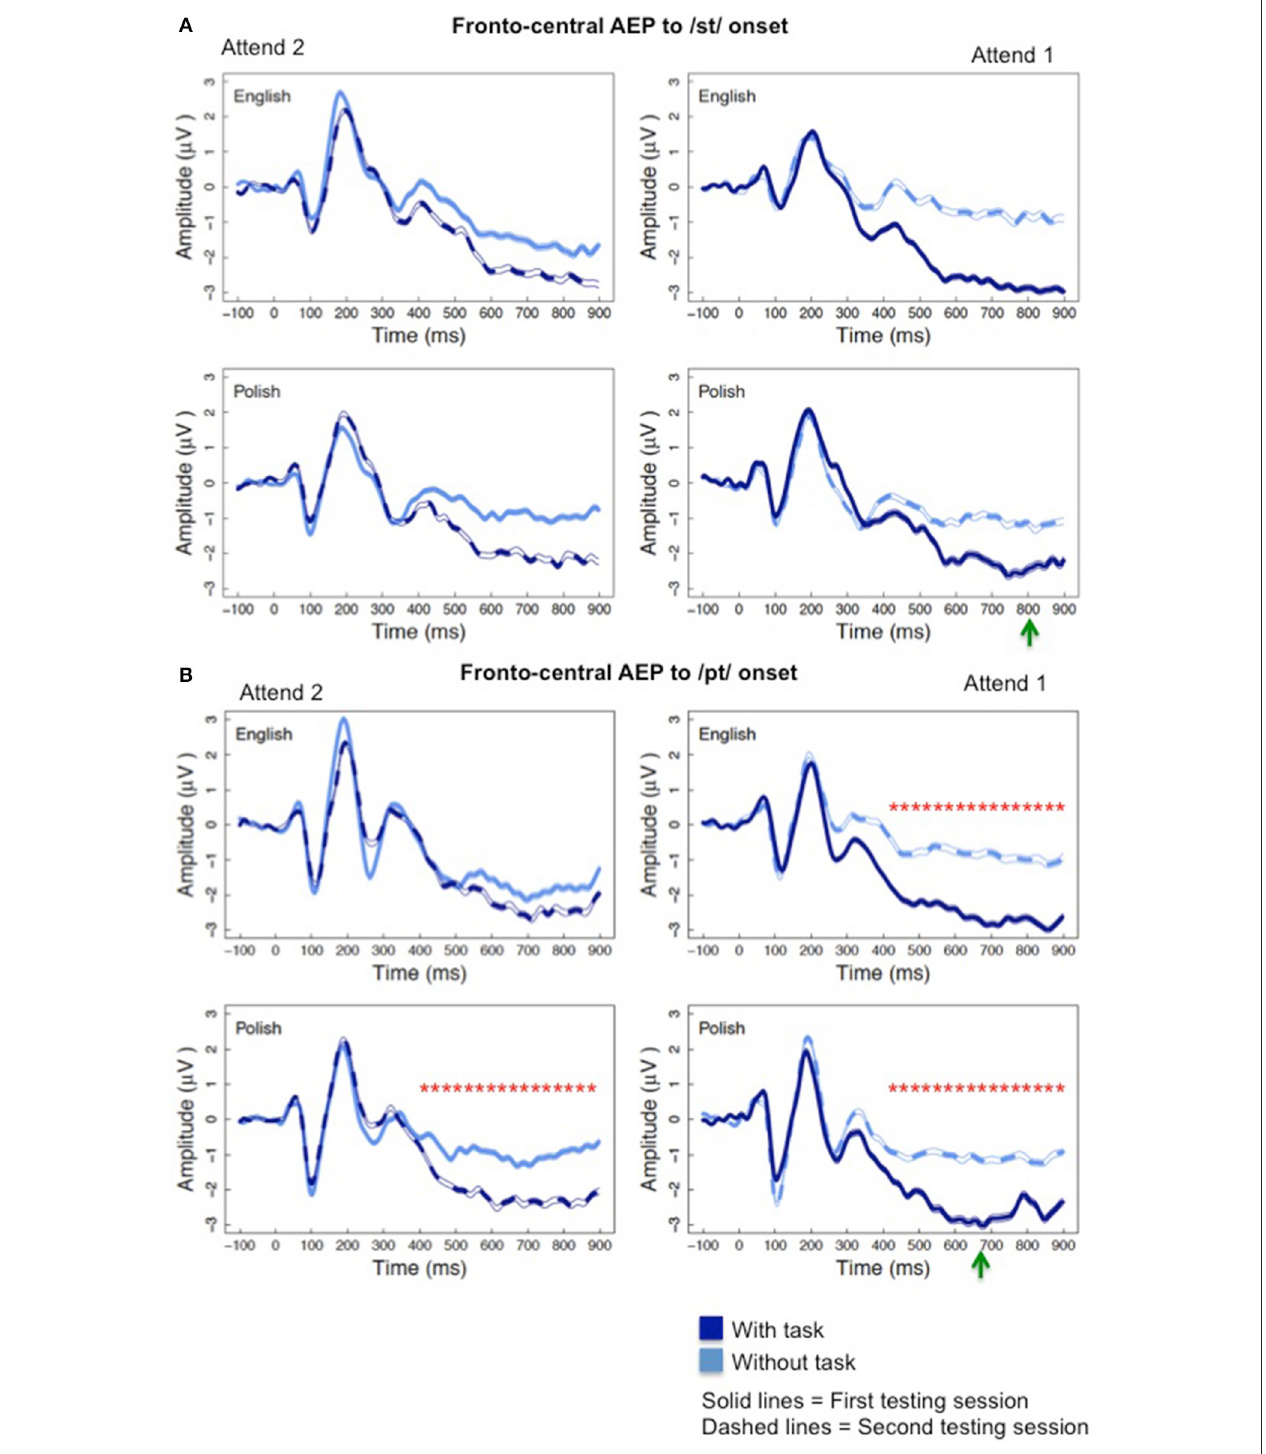
FIGURE 3 | The effect of attention on the fronto-central AEP (A) to the /st/ onset. Notice the negative-going deflections for the “with task” conditions (dark blue, solid and dotted lines) relative to the “without task” conditions that was more pronounced when the “with task” condition occurred during testing session 1 (dark blue, solid lines) within the “Attend 1” sequence of condition presentation (right). (B) Graphs illustrate the significant effect of attention on the fronto-central AEP between 400 and 900ms that occurred to the /pt/ onset cluster for the Polish participants, but not the English participants, in the “Attend 2” presentation groups (left). The green arrows depict the earliest possible appearance for the second word in the word pairs.*Significant effects of attention as described within text.